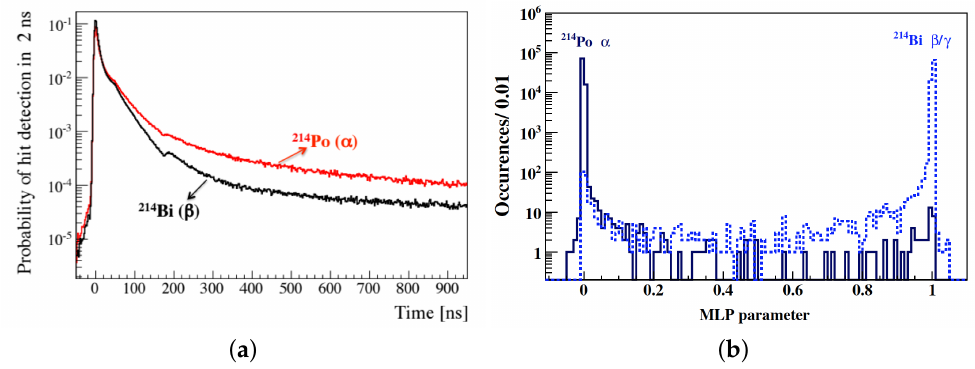
Figure 2. α and β separation in Borexino. ( a ) Hit time profiles for 214 Po- α s’ (in red) and 214 Bi- β s’ (in black) after TOF subtraction. From [21]. ( b ) The MLP variable, shown for the same events, characterized by a high separation power between α and β / γ -like events. From